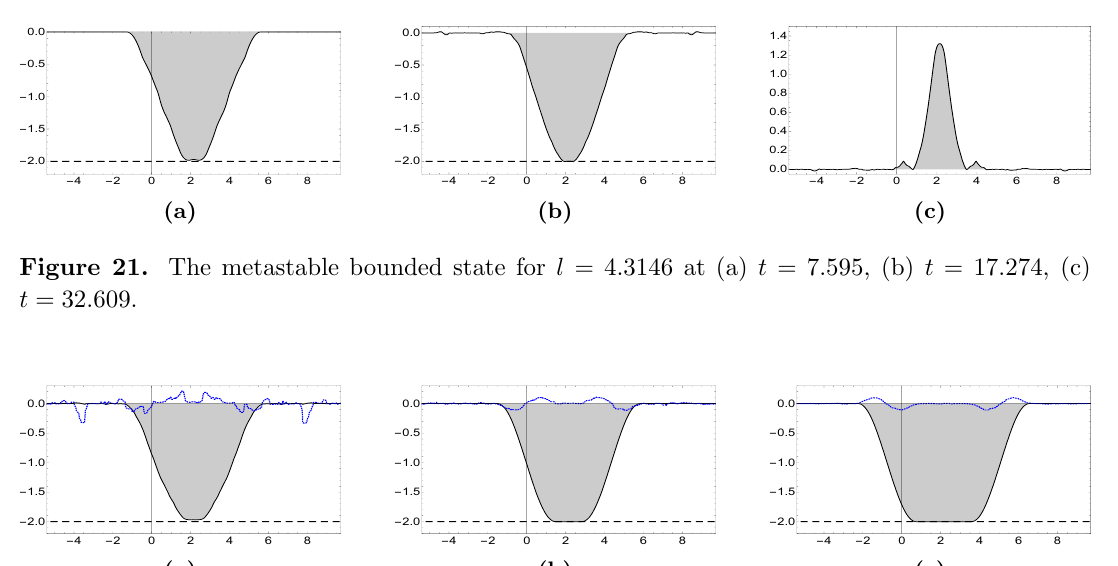
initial phase of the evolution. For this reason the energy of the initial con(cid:12)guration must be a somewhat larger than E = (cid:25) . In consequence, l = l